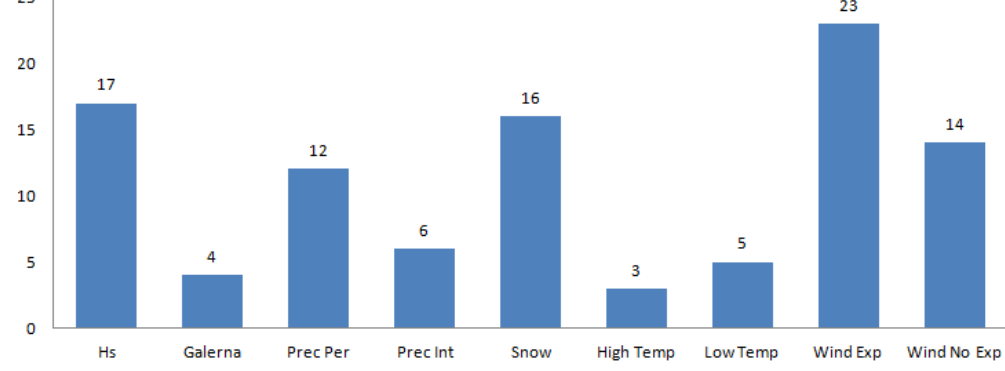
Figure 6. Warning causes frequency (%), for 2004–2010 period.